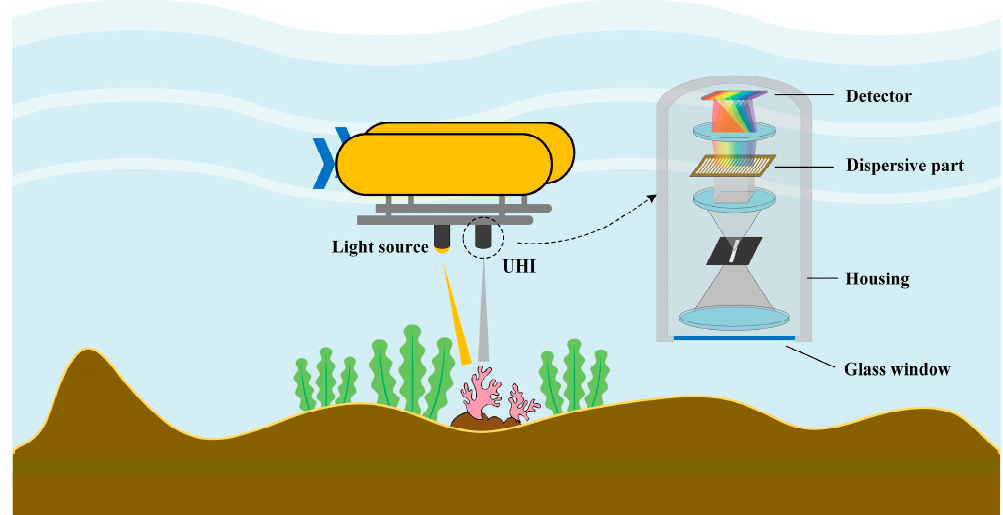
Figure 1. A schematic diagram of underwater hyperspectral imaging (UHI) for seafloor mapping.